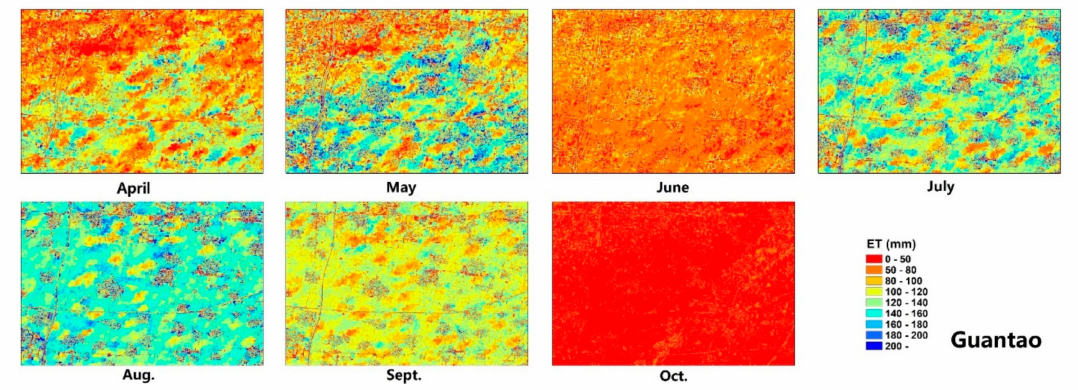
Figure 7. The spatial distribution of the ET allocation results in the Guantao research region.